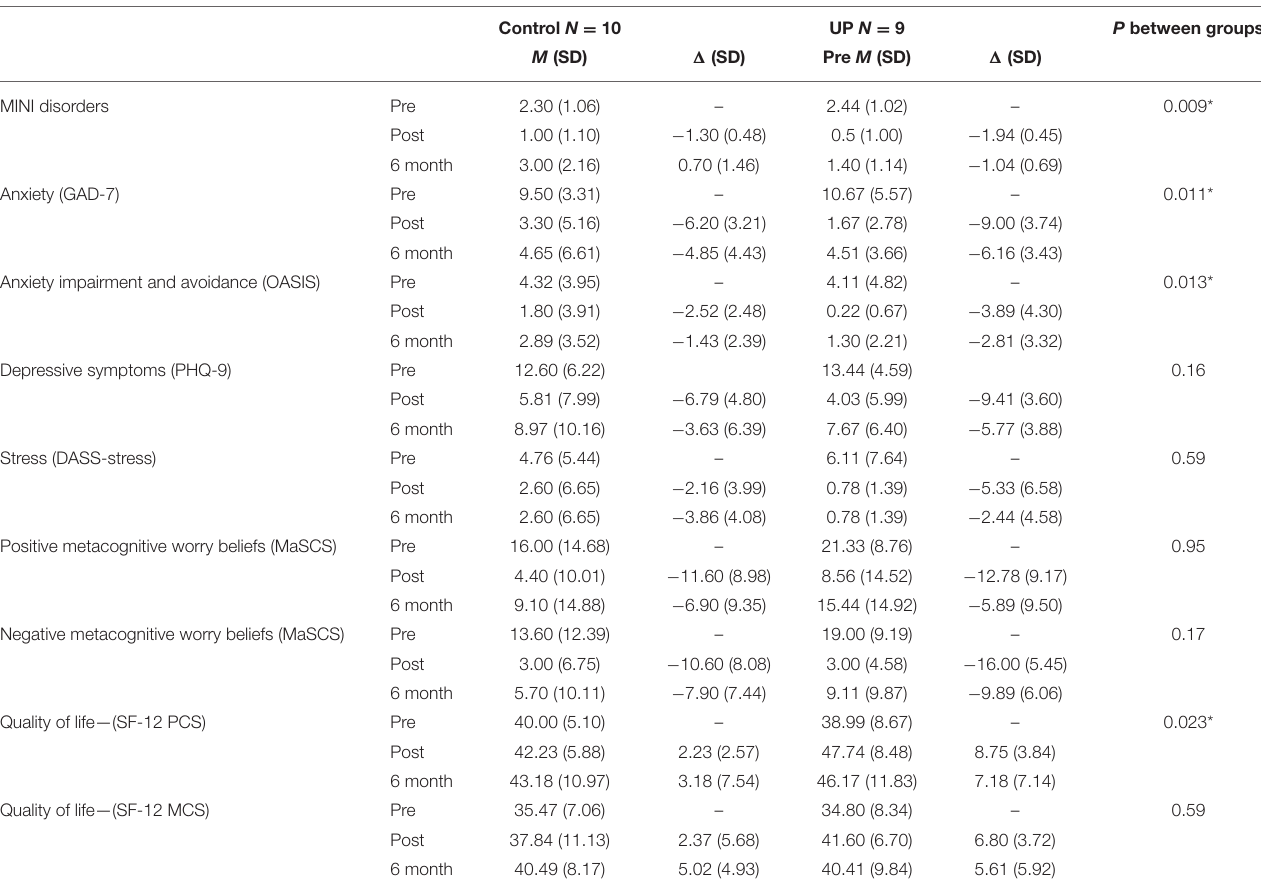
TABLE 3 | Change in psychological outcomes for patients randomized to unified protocol vs. enhanced usual care.